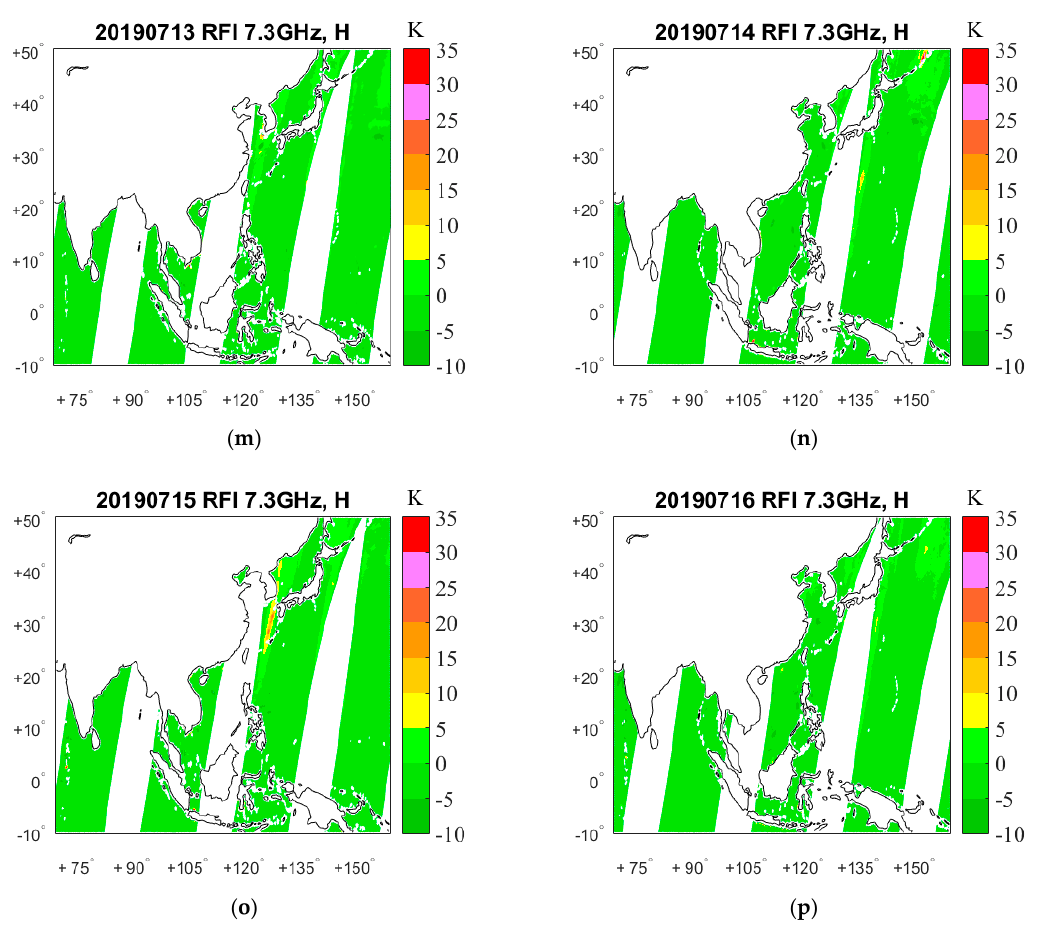
Figure 1. Spatial distribution of 7.3 GHz-H RFI, using GRDM over East Asian waters during the period 1–16 July 2019. ( a ) 1 July; ( b ) 2 July; ( c ) 3 July; ( d ) 4 July; ( e ) 5 July; ( f ) 6 July; ( g ) 7 July; ( h ) 8 July; ( i ) 9 July; ( j ) 10 July; ( k ) 11 July; ( l ) 12 July; ( m ) 13 July; ( n ) 14 July; ( o ) 15 July; ( p ) 16 July.